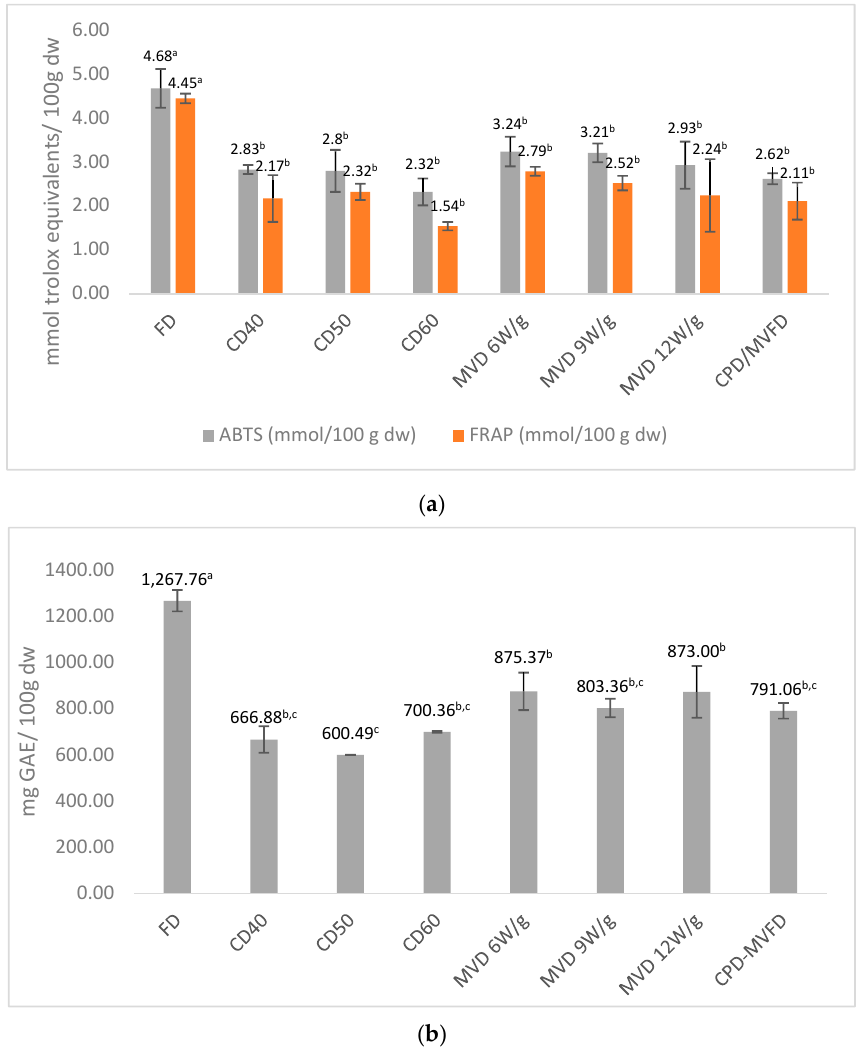
Figure 2. Effect of the FD, CD, MVD, and CPD-MVFD on the antioxidant capacity ( a ) and total polyphenolic content ( b ) of dried M. koenigii leaves. ( a ): The same letters next to the bars indicate no significant differences in mean values at the level of 5%, according to Tukey’s significant difference test; ( b ): The same letters next to the bars indicate no significant differences in mean values at the level of 5%, according to Tukey’s significant difference test.